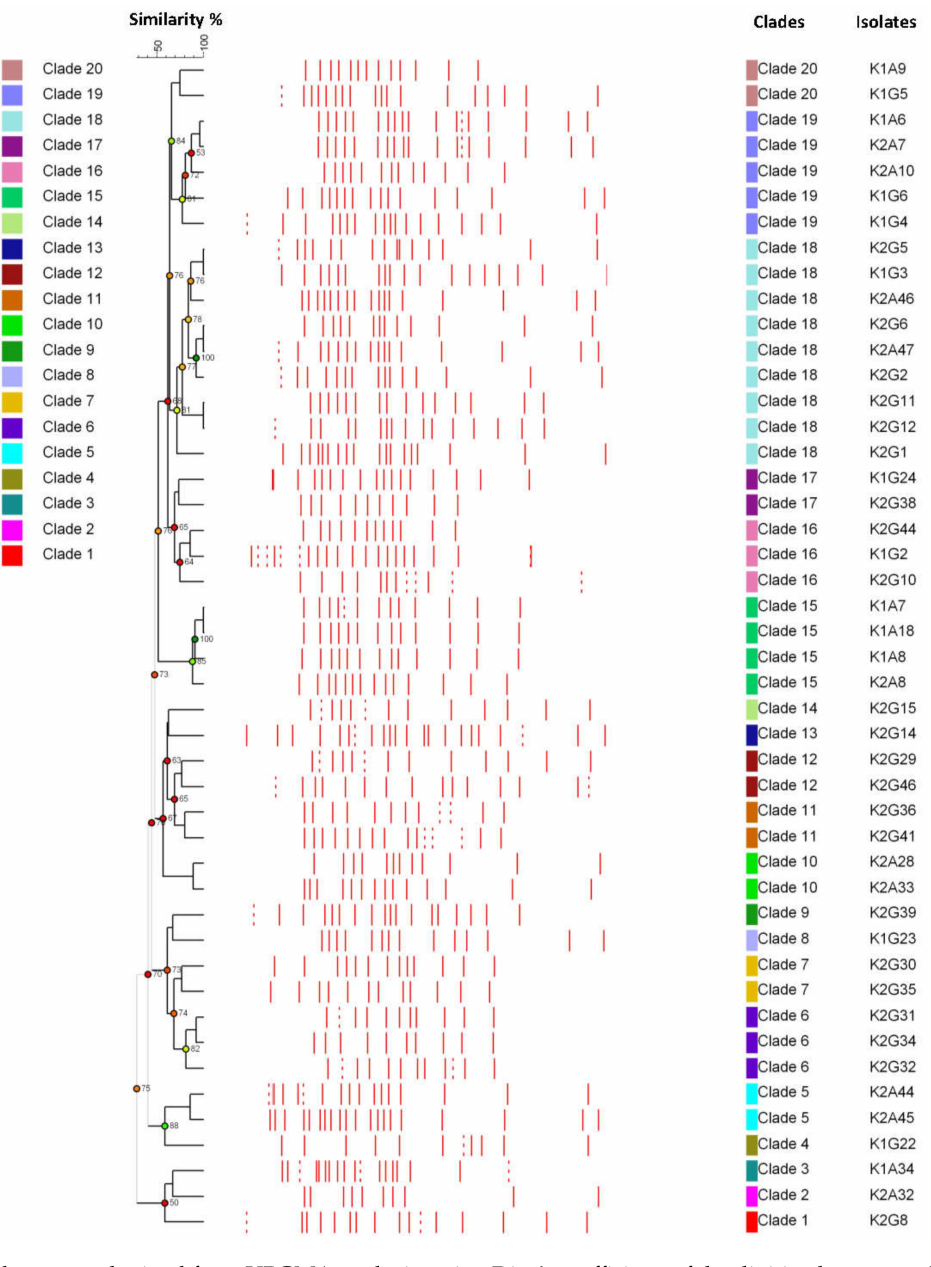
Figure 2. Dendrograms obtained from UPGMA analysis, using Dice’s coefficient, of the digitized patterns obtained from (GTG) 5 rep-PCR. The similarity threshold for biotypes discrimination was 70%. The cophenetic coefficient is represented by numbers and dots colored as red–orange–yellow–green, based on the branch